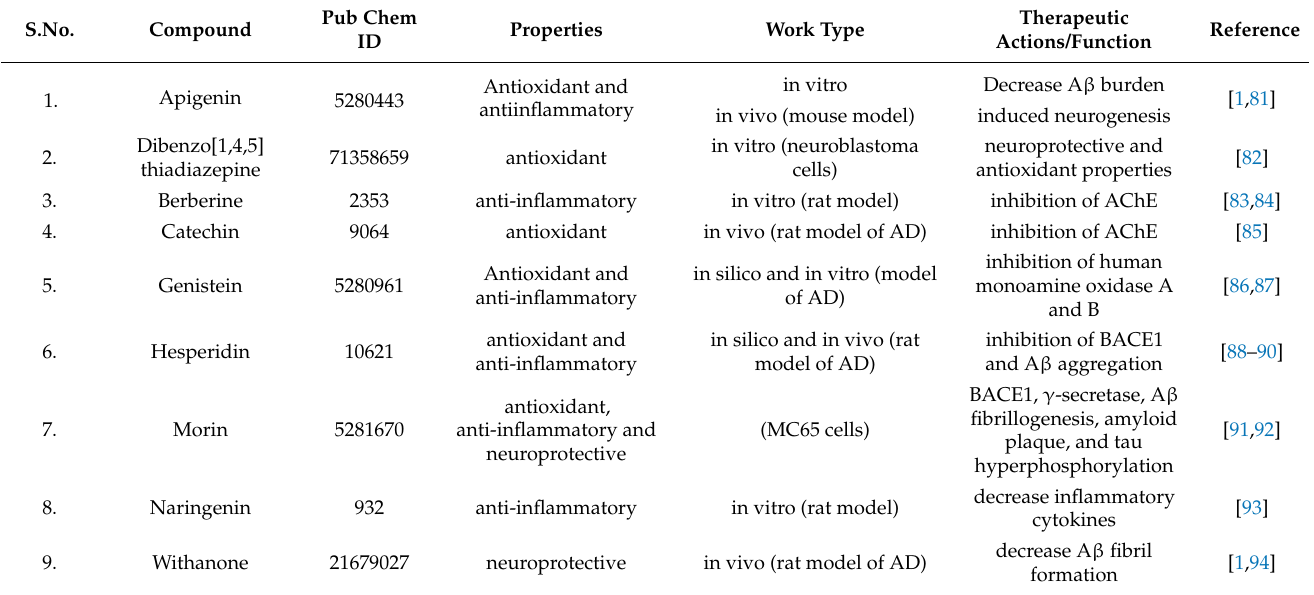
Table 1. List of several natural compounds that have potential to inhibit AChE, BuChE, BACE1 and MAOs activity during in silico, in vitro, and in vivo